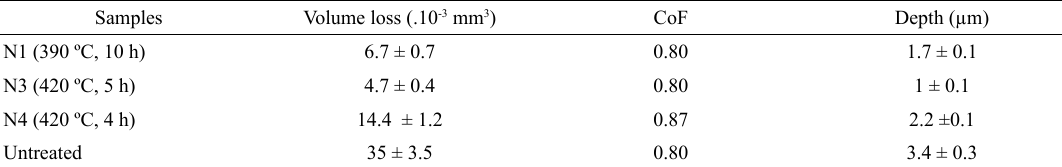
Table 3. Wear results (Pin on disk)